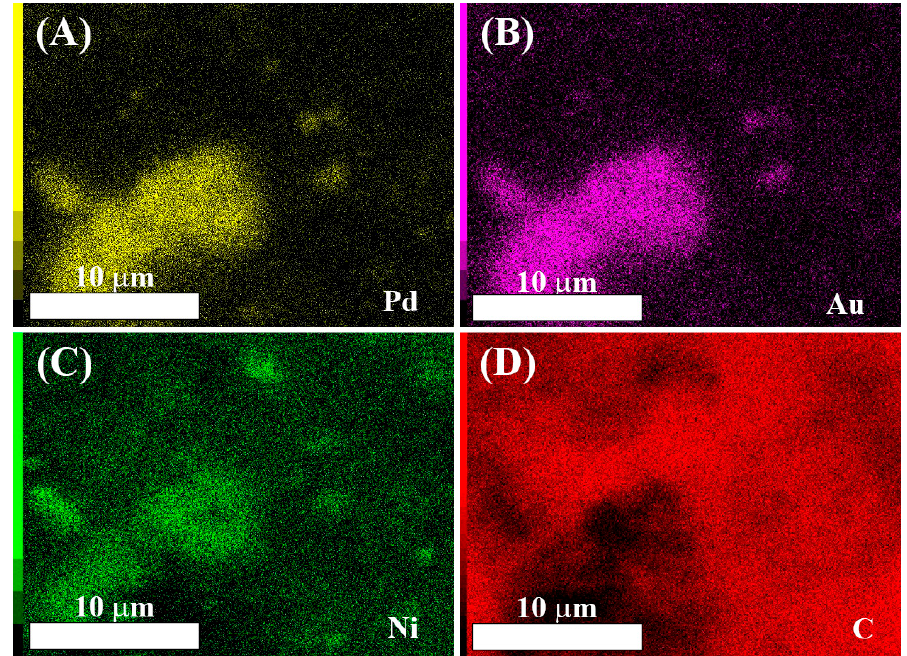
Figure 3. Elemental maps of ( A ) Pd, ( B ) Au, ( C ) Ni, and ( D ) C of PdAuNi/C SBIPA obtained by EDX spectroscopy at 10 kV.